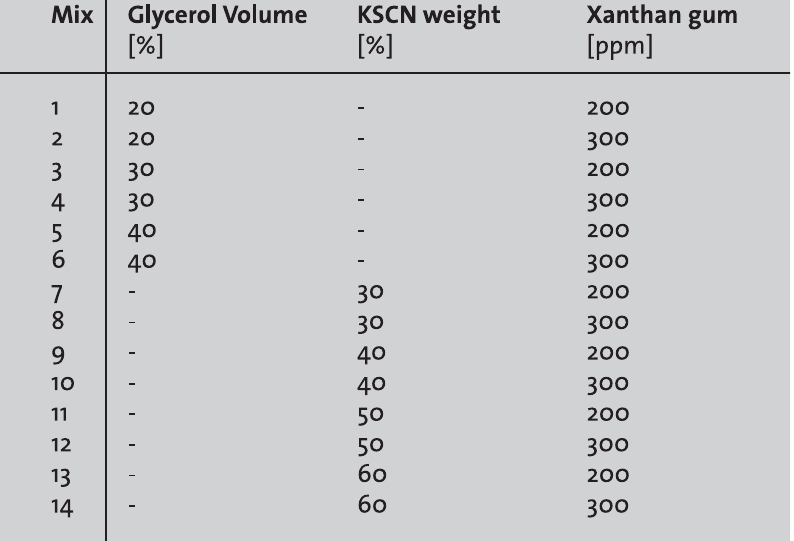
Table 1: Tested mix